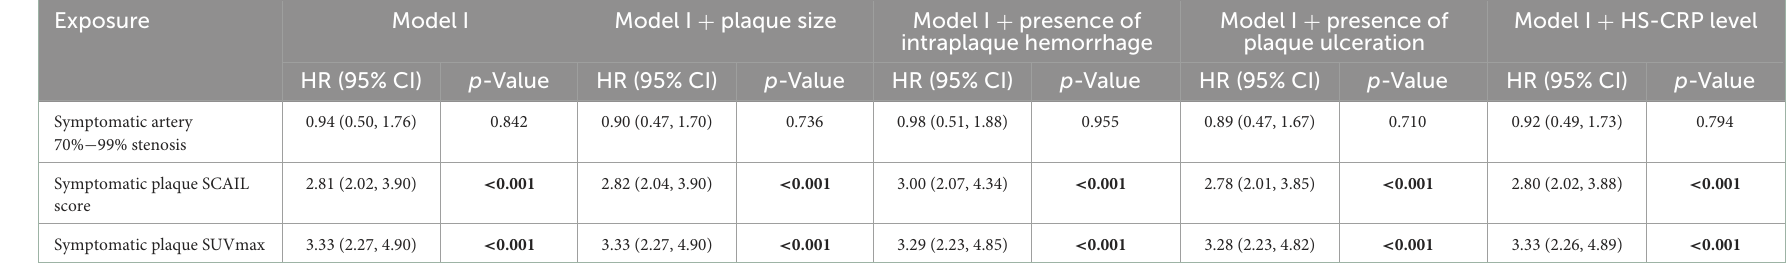
TABLE 3 Cox proportional-hazards models analyzing the association between 90-day TIA or MACE and symptomatic plaque stenosis severity, SCAIL score, and SUVmax.